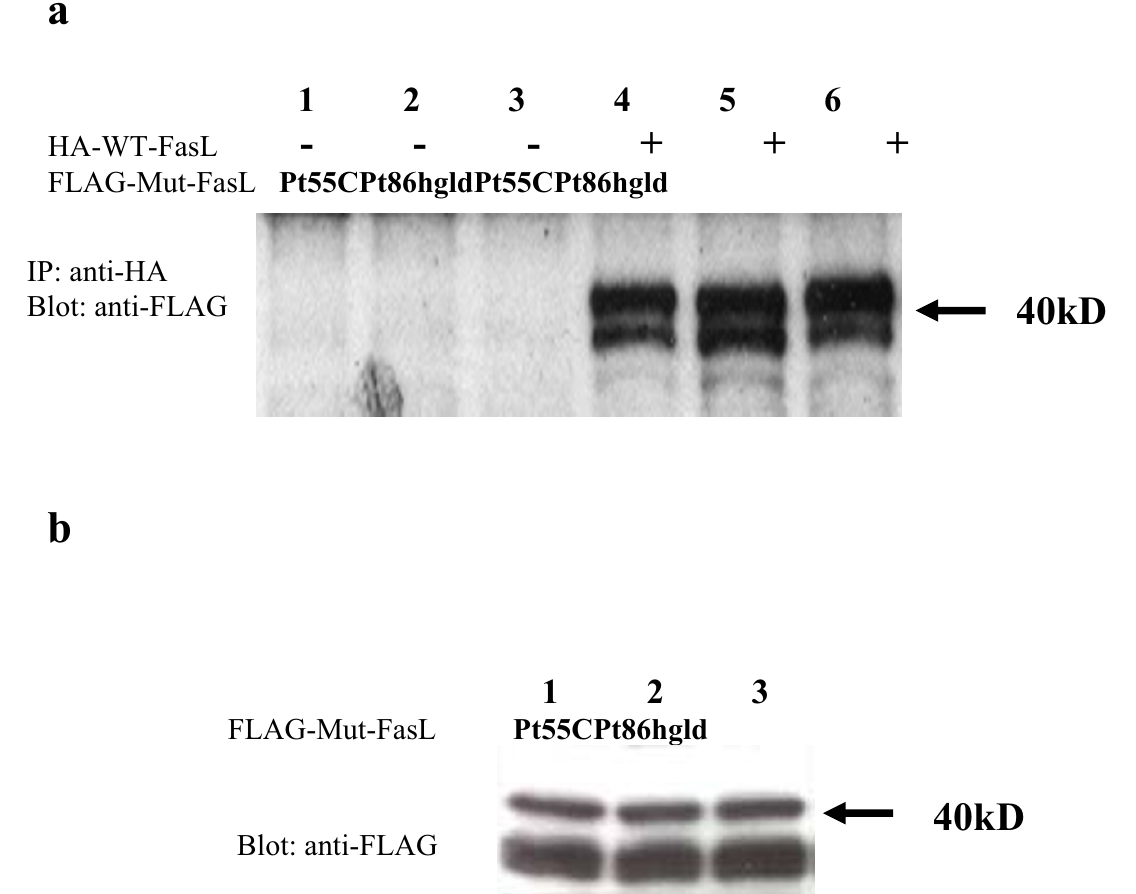
Figure 6 Physical association of FLAG-tagged mutant FasL with HA-tagged wild type FasL. (a) Lanes 1, 2 and 3 contain extracts from cells transfected with the FLAG-tagged mutant FasL constructs (A320G, A530G and h gld ) alone and lanes 4, 5 and 6 are from cells co-transfected with one of FLAG-tagged mutant FasL constructs and the HA-tagged wild type FasL construct. An anti-HA antibody was used for the immunoprecipitation and an anti-FLAG antibody was used for Western blot analysis. The double bands appearing at about 40 kD represent two FasL isoforms with different glycosylation patterns. (b) Western blot analysis of transfected cell lysates. The FLAG-tagged FasL with the mutations (lanes 1–3) were expressed in 293T cells, and FasL expres- sion was detected by Western blotting with an anti-FLAG